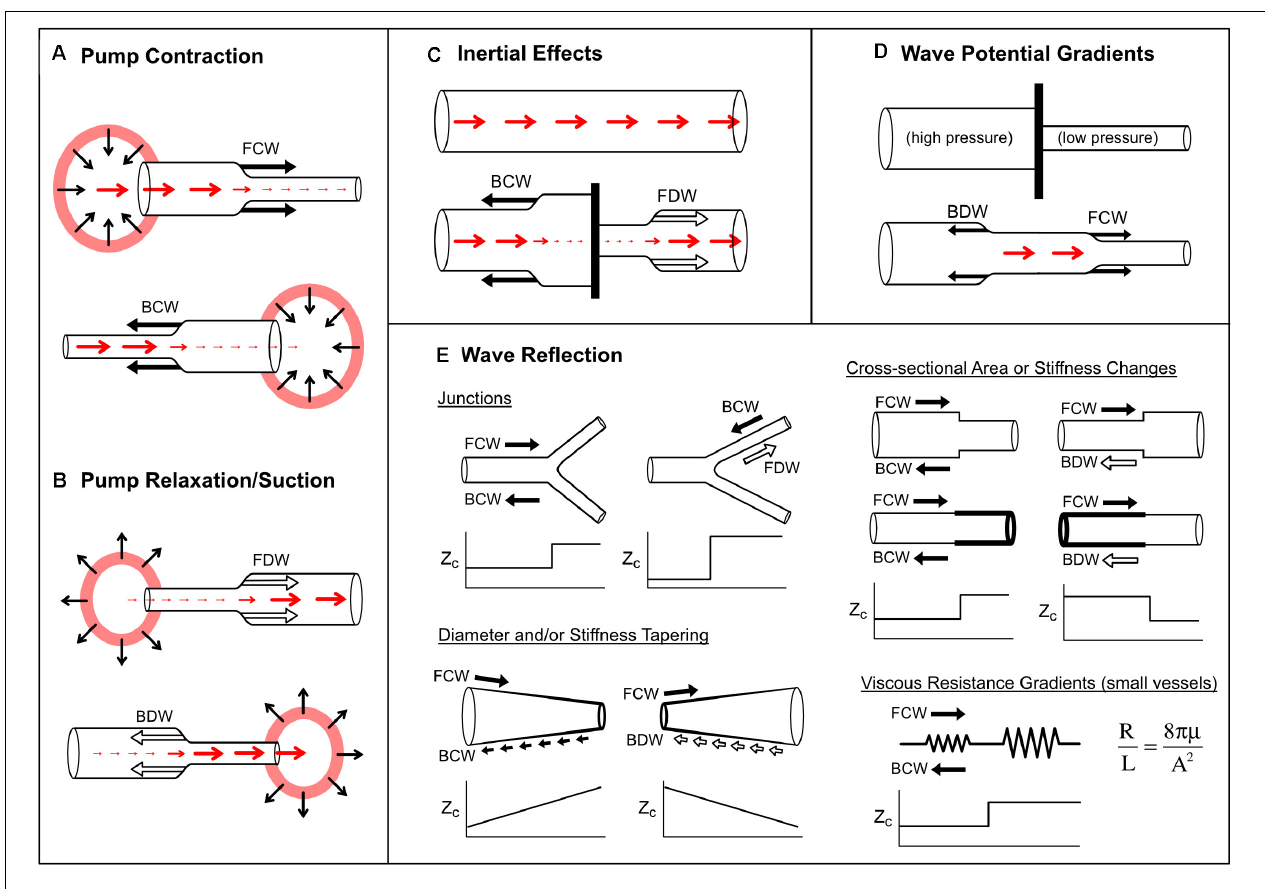
FIGURE 7 | Mechanisms that produce pressure/flow waves in blood vessels. See text for detailed explanation. Red arrows indicate blood flow or velocity (larger arrow means higher flow/velocity). Solid black arrows indicate compression (pressure-increasing) waves, while outlined black arrows indicate decompression (pressure-decreasing) waves. Panels (A,B) illustrate wave generation via active pump contraction and relaxation respectively. In panel (C) , a barrier is placed in a vessel that contains flowing blood. In panel (D) , a barrier is removed between two vessels containing blood at different pressures. In panel (E) , increases or decreases in characteristic impedance ( Z c ; or combined Z c in the case of the bifurcation) are plotted versus horizontal position. Viscous resistance per unit length (R/L, given by Poiseuille’s law, where µ is blood viscosity and A is cross-sectional area) is small in large vessels but becomes dominant in small